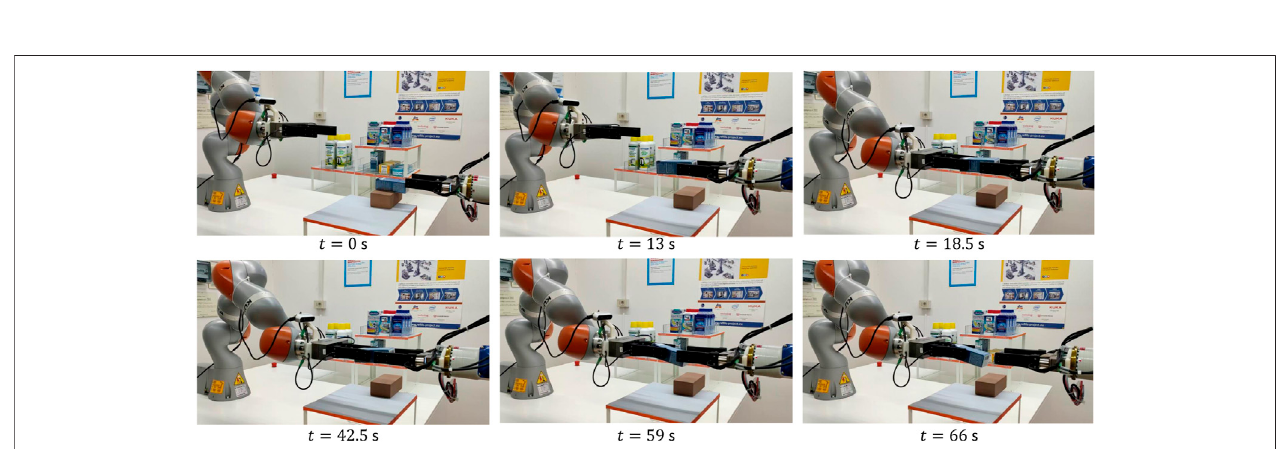
FIGURE 12 | Third experiment (Object C): detail of the H2R physical handover phase (top) ; detail of the R2H physical handover phase (bottom) .